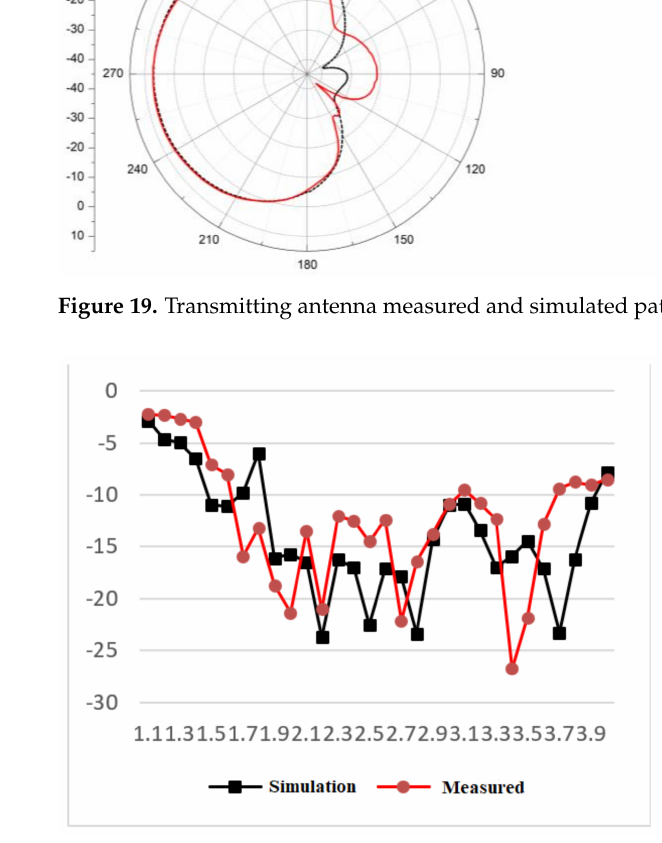
Figure 20. Transmitting antenna simulation and measured S11 curve.